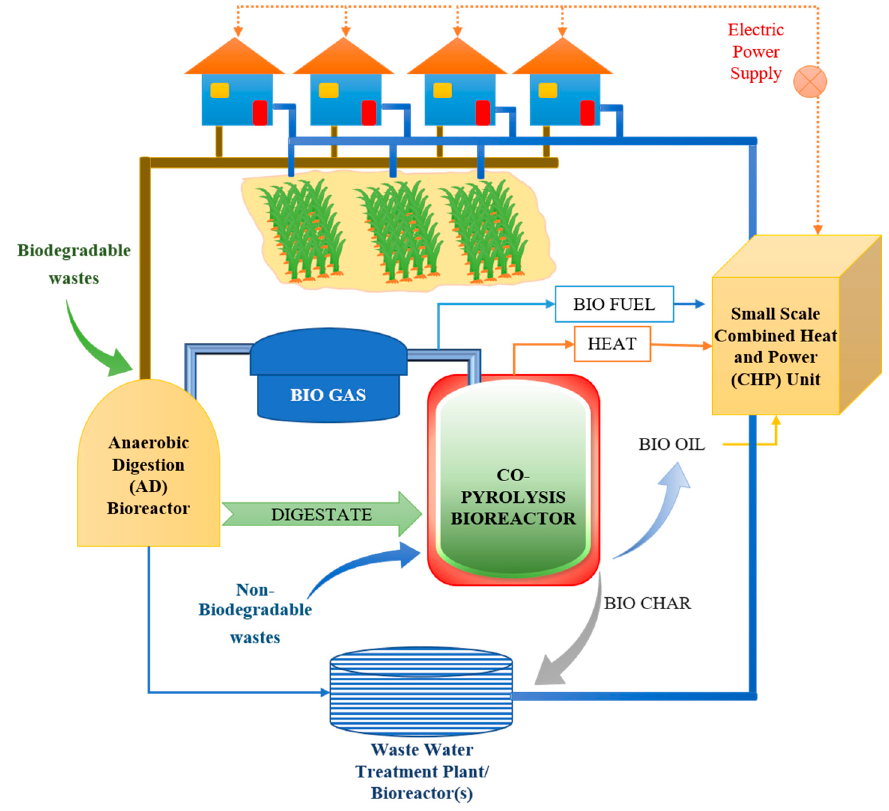
Figure 2. Application of co-pyrolysis bioreactors in integrated green energy approach.